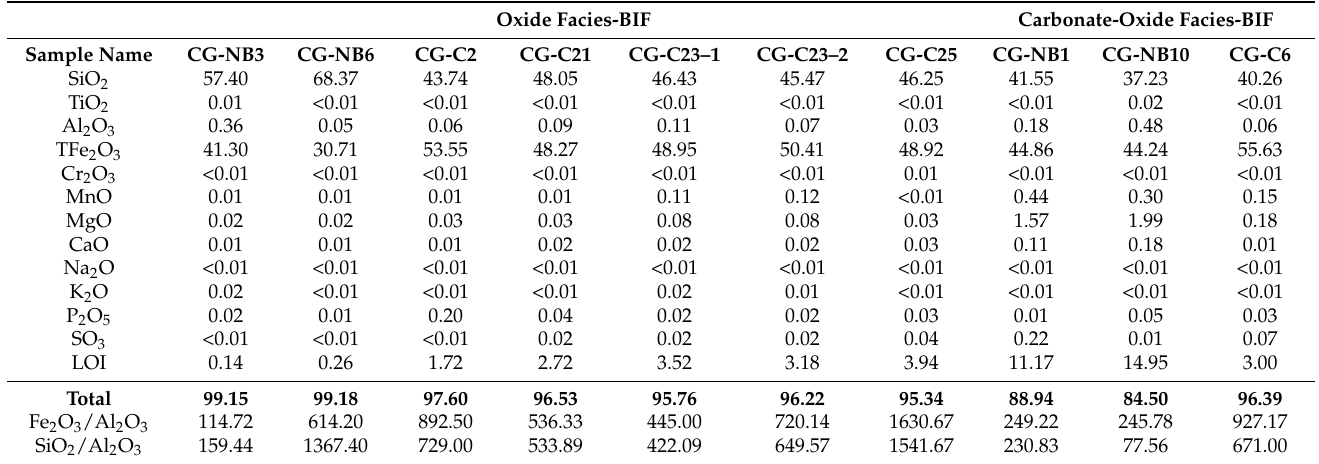
Table 2. Major element oxide composition (wt.%) and ratios of the Nababa BIF. Oxide Facies-BIF Carbonate-Oxide Facies-BIF